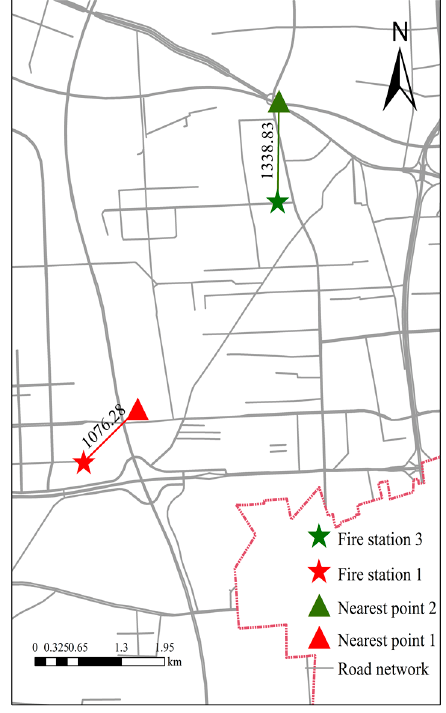
Figure 5. Distribution of fire stations and nearest points.